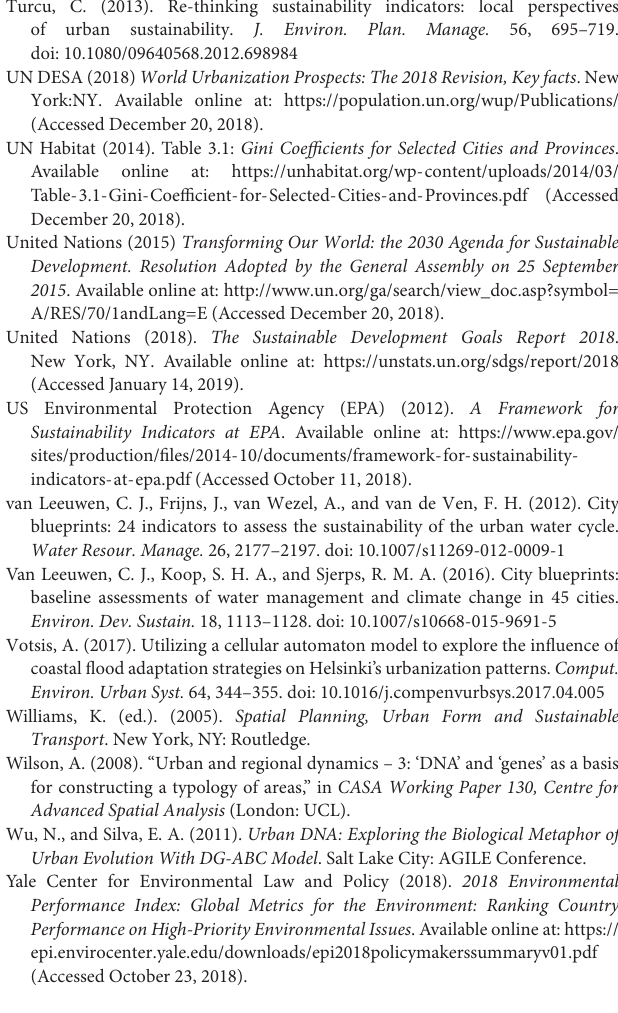
Table-3.1-Gini-Coefficient-for-Selected-Cities-and-Provinces.pdf (Accessed December 20,